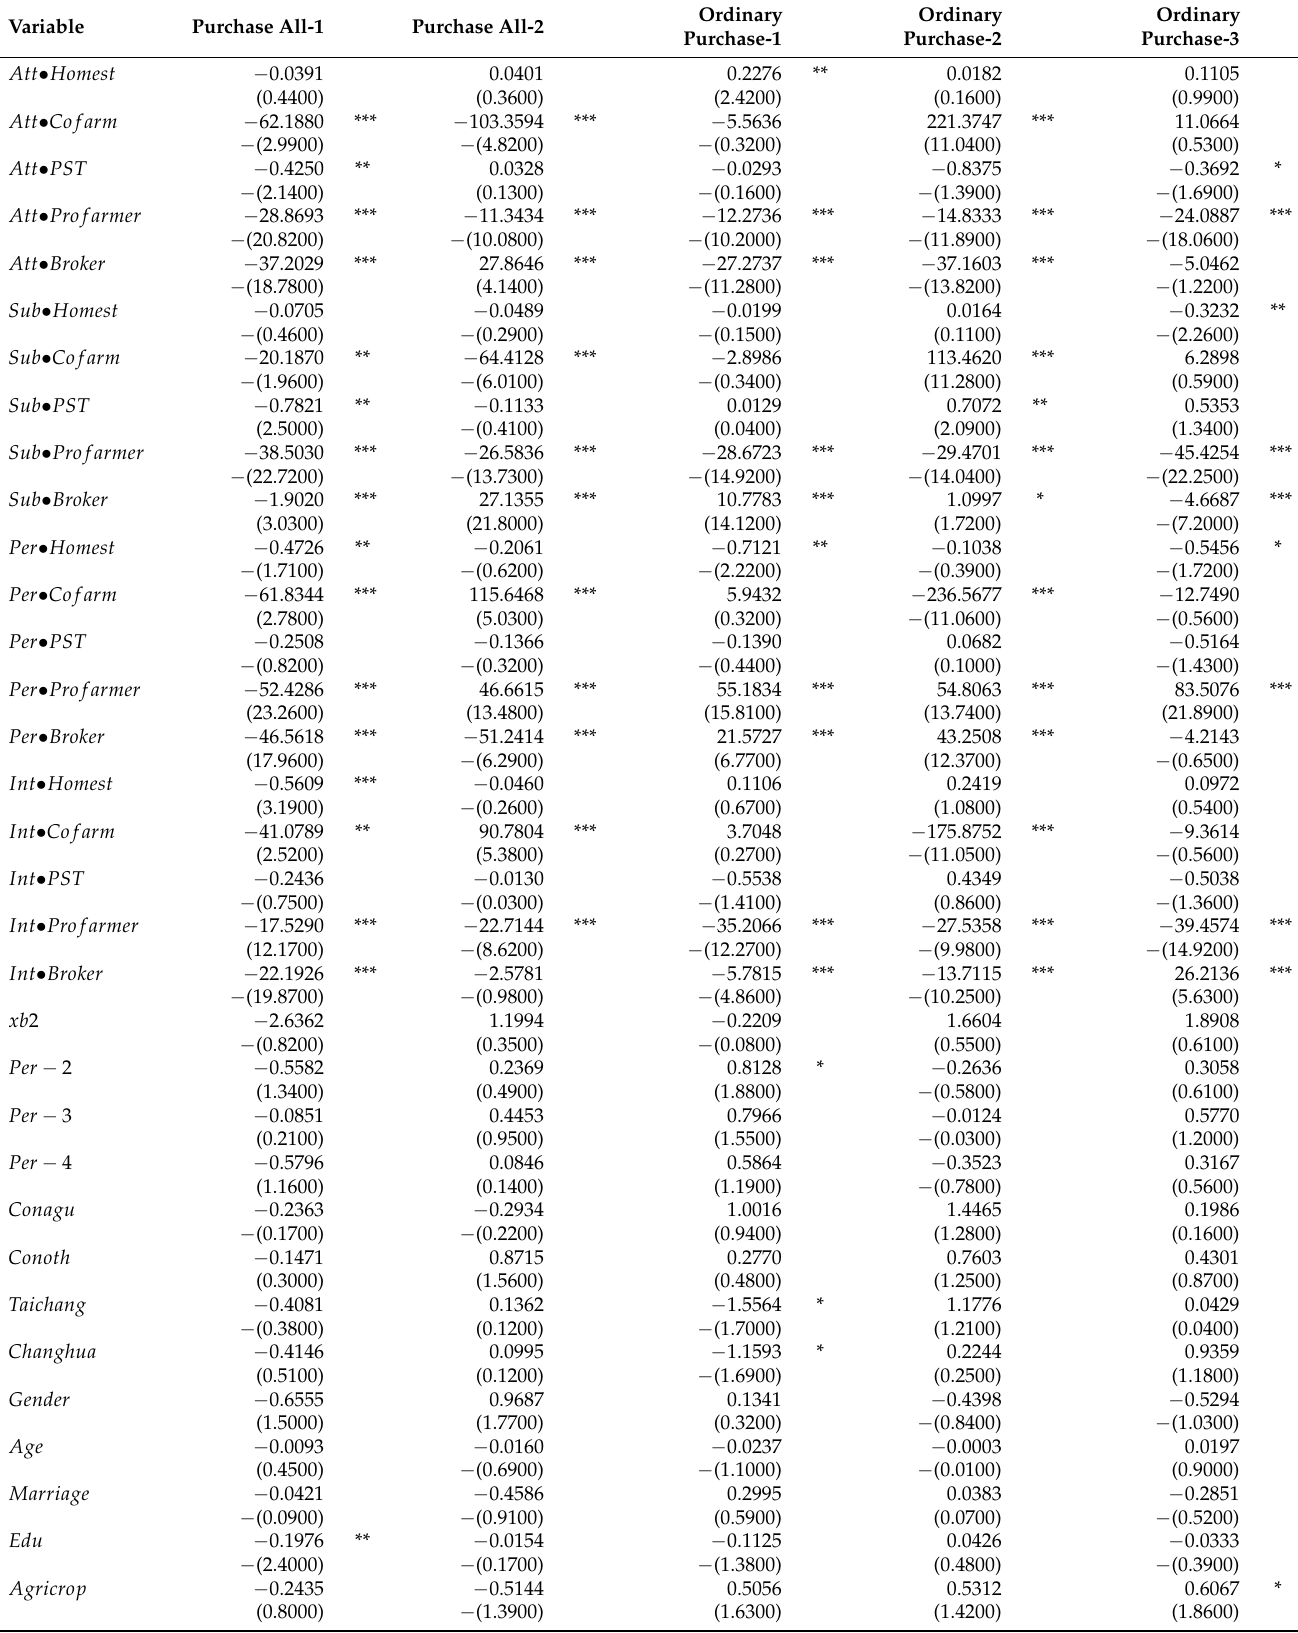
Table 4. Estimation results of selecting different types of contract